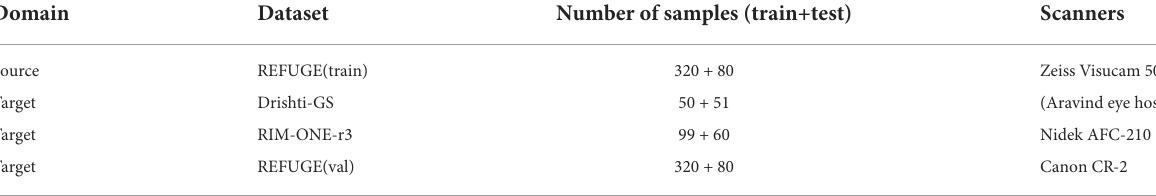
TABLE 2 Public fundus datasets used for training and testing in experiments.